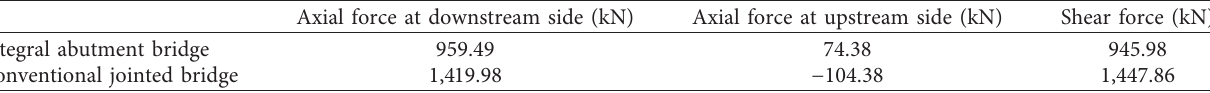
Table 11: Reaction of